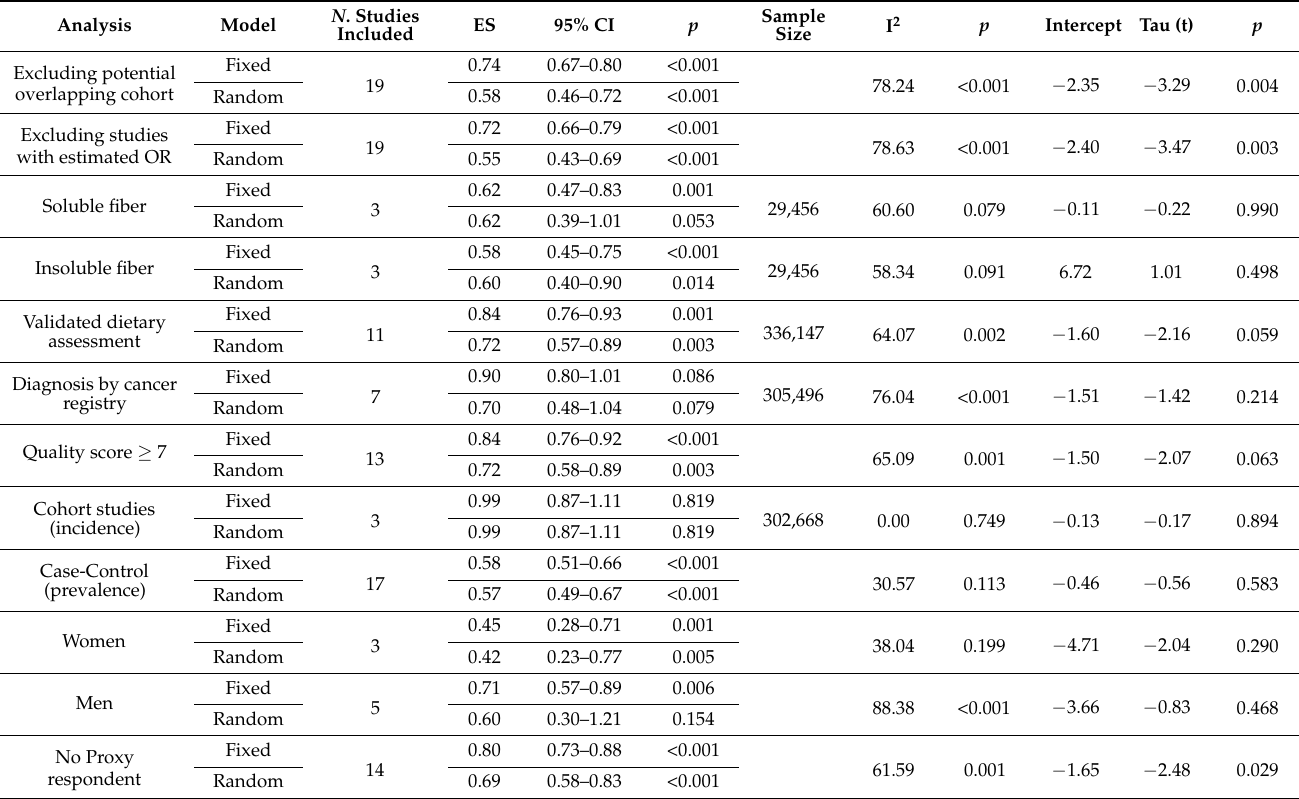
Table 3. Results of the sensitivity and subgroup